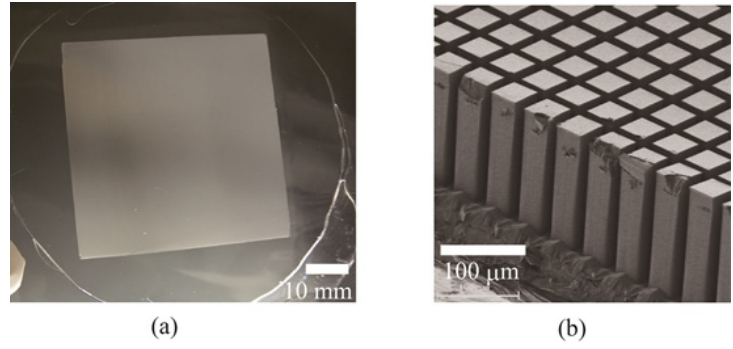
Table 1. Sizes of patterns on the silicon master and UV imprinted sample. Point